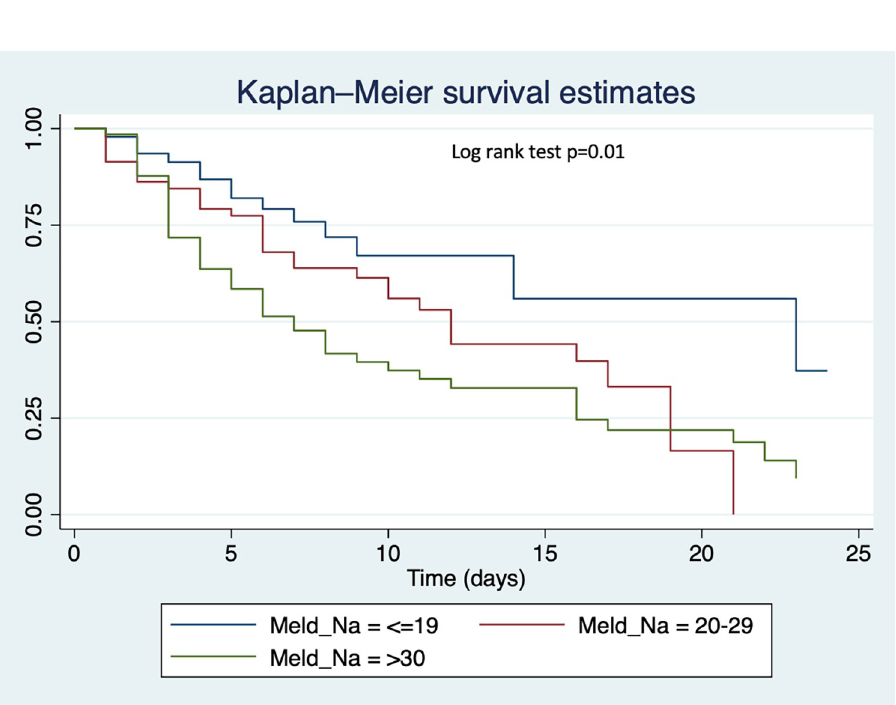
Fig 5. Kaplan-Meier survival curves comparing in-patient survival by MELD-Na score.